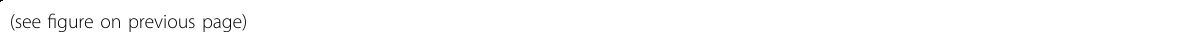
Fig. 3 SatIII recruits TOP2A to nSB foci thereby protecting cells from DNA double strand breaks. A Representative images of the SatIII RNA and TOP2A co-localization in HeLa cells exposed to HS conditions (1 h at 44 °C) or HS plus 24 h recovery at 37 °C and DMSO or etoposide 10 µM treatment. SatIII RNA was stained using smFISH (red), TOP2A was stained using a protein-speci fi c antibody (green). Scale bar, 10 µm. B Quanti fi cation of ( A ) by counting the number of foci per cell. Quanti fi cation was performed using an automated ImageJ pipeline, n = 5. C Cell cycle assay utilizing Hoechst staining was performed to clarify SatIII expression patterns during the cell cycle. HeLa cells were subjected to HS (1 h at 44 °C) or control conditions, fi xed and stained with Hoechst staining dye. The cells were monitored over the course of the cell cycle in an automated HCS microscope. A minimum of 3000 cells, separated in n = 6 replicates, were quanti fi ed for each condition. D Effects of SatIII RNA knockdown on DNA damage was investigated by immuno fl uorescence staining for 53BP1. HeLa cells were transfected with siSatIII and scramble RNA (control), respectively. Cells were then exposed to HS conditions (1 h at 44 °C) or constant 37 °C and treated with 20 µM etoposide or DMSO. After 24 h, cells were fi xed and stained with a protein-speci fi c 53BP1antibody (green). Counterstaining of nuclei was performed with Hoechst stain. Imaging and analyses were performed utilizing HCS microscope-based quanti fi cations of the staining. Error bars represent the standard deviation of the mean of three replicates. Two-tailed paired Student ’ s t test signi fi cant P -values are marked: < 0.05 with (*), < 0.01 with (**), < 0.001 with (***). Scale bar, 10 µm. E RNA immunoprecipitation in HeLa cells subjected to three different treatment conditions: HS (1 h at 44 °C), HS with a 24 h recovery time at 37 °C (HS + rec), and non-HS conditions (nHS, 37 °C). Chromatin was sheared by sonication and precipitated using an antibody against human TOP2A or HSF1. Binding to SatIII was analyzed using qPCR. HSF1 was used as a positive control. Figure shows a typical result for two biological replicates, each with three technical replicates. F Caspase-3/-7 assay of HeLa cells either transfected with the siRNA targeting SatIII (siSatIII) or control siRNA (siCo). After transfection, cells were treated as indicated with etoposide or a DMSO control. Error bars represent standard deviation of the mean of three replicates. Two-tailed paired Student ’ s t-test signi fi cant P -values are marked: < 0.05 with (*), < 0.01 with (**), < 0.001 with